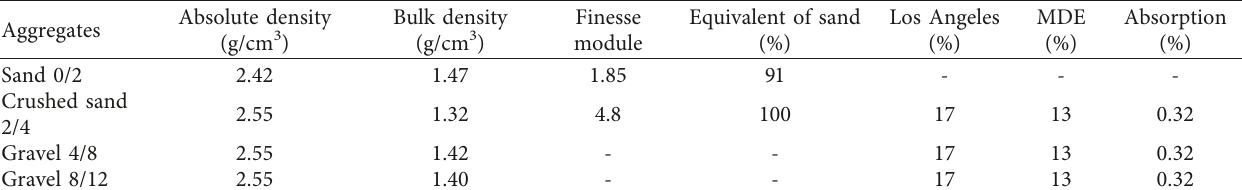
Table 5: Physical characteristics of aggregates.